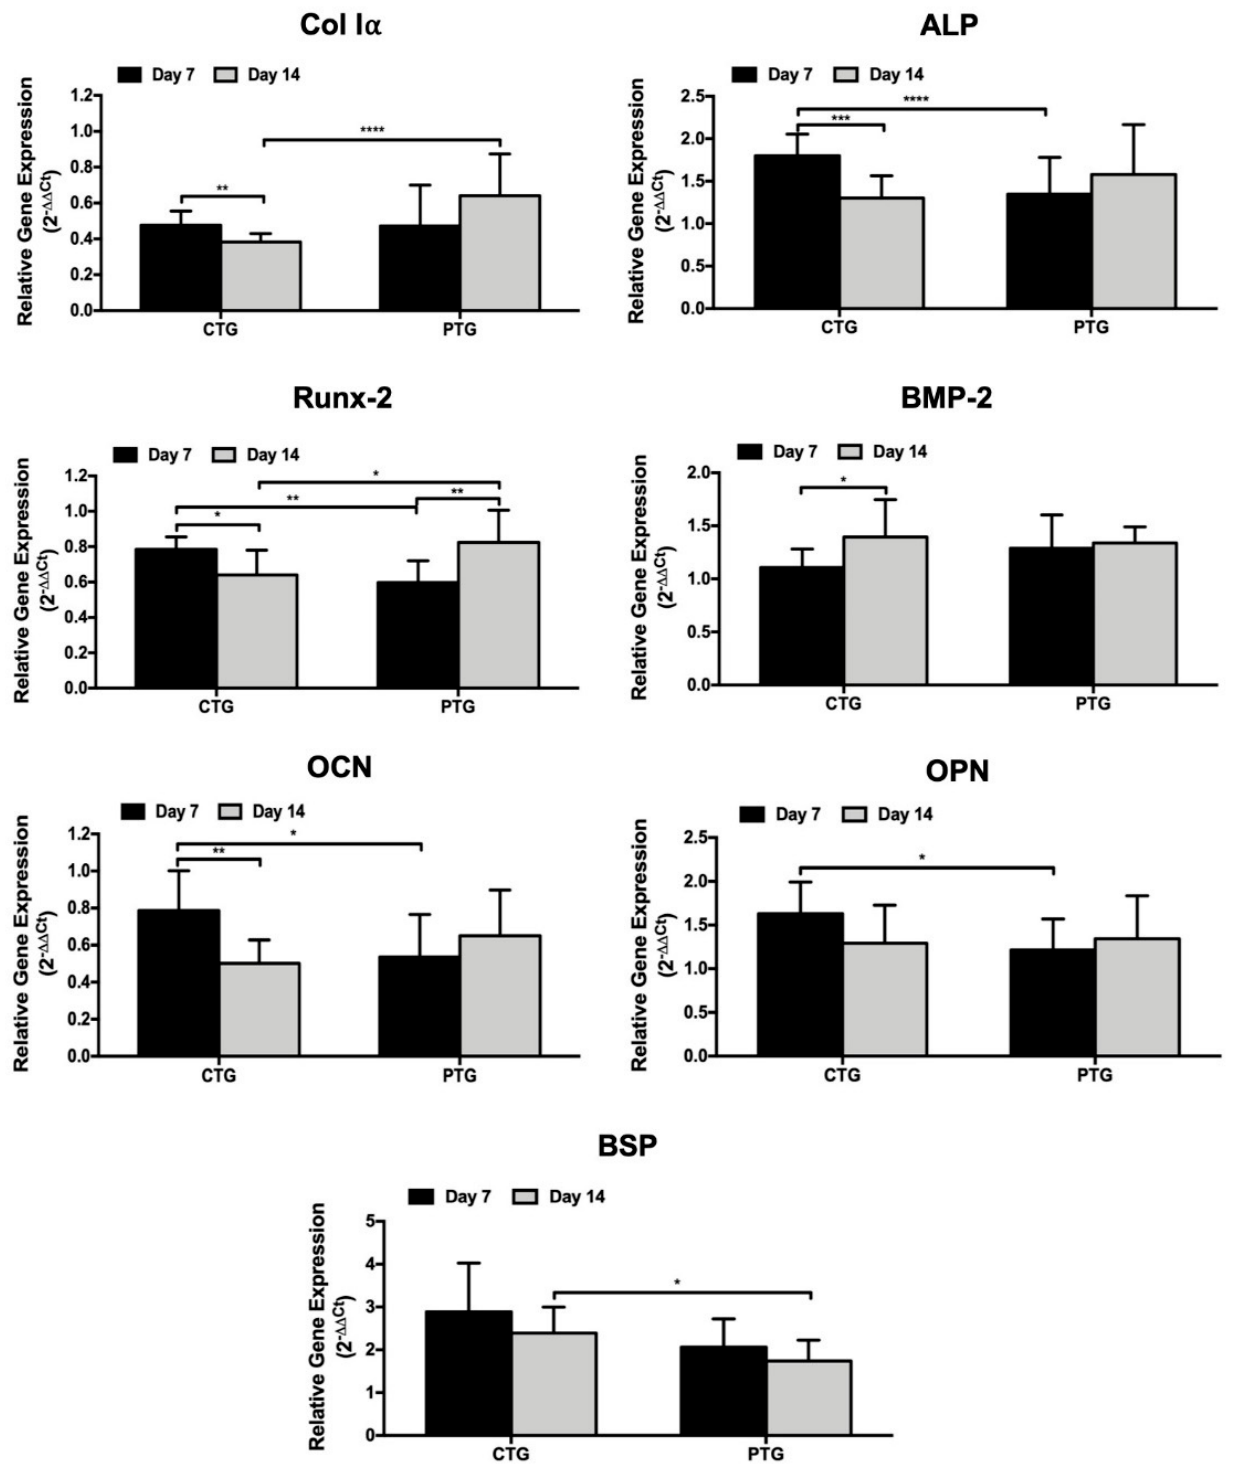
Figure 7. Gene expression profile of osteogenic-related markers. Real-time RT-PCR results of the osteogenic-related transcripts Col I α , ALP, Runx-2, BMP-2, OCN, OPN and BSP by the SaOs-2 cells cultured in the CTGs and PTGs up to 14 days.(* p < 0.05; ** p < 0.01; *** p < 0.005; **** p < 0.0001).